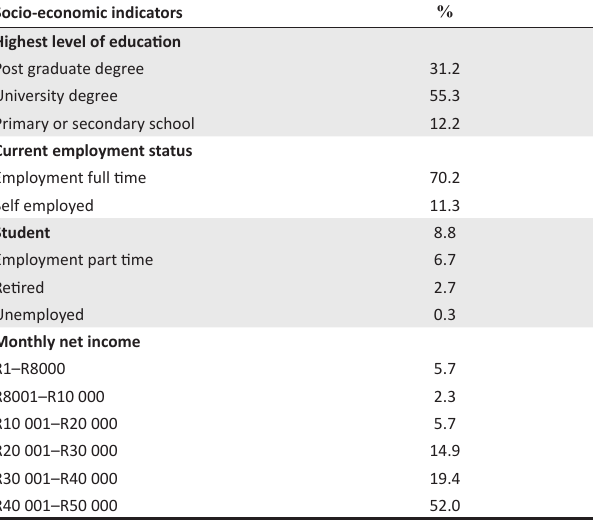
TABLE 3: Socio-economic